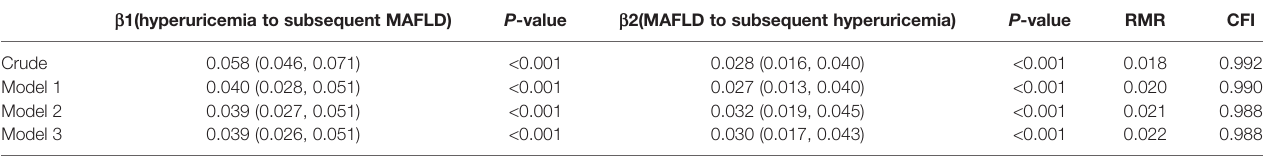
MAFLD, metabolic dysfunction-associated fatty liver disease; RMR, root mean square residual; CFI, comparative fi tness index. Model 1: adjusted for age,